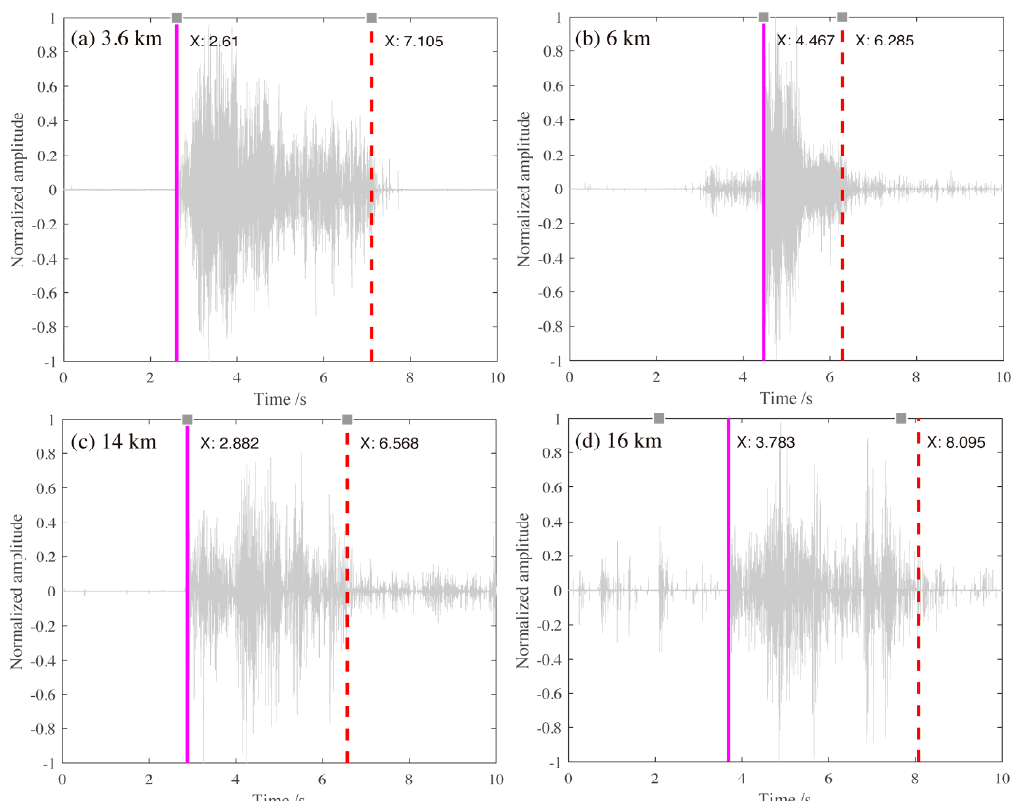
Figure 10. Endpoint detection results of the thunders initiated at ( a ) 3.6 km, ( b ) 6 km, ( c ) 14 km, and ( d ) 16 km, respectively. The solid pink line represents the start time of thunder, and the dotted red line represents the end time of thunder.